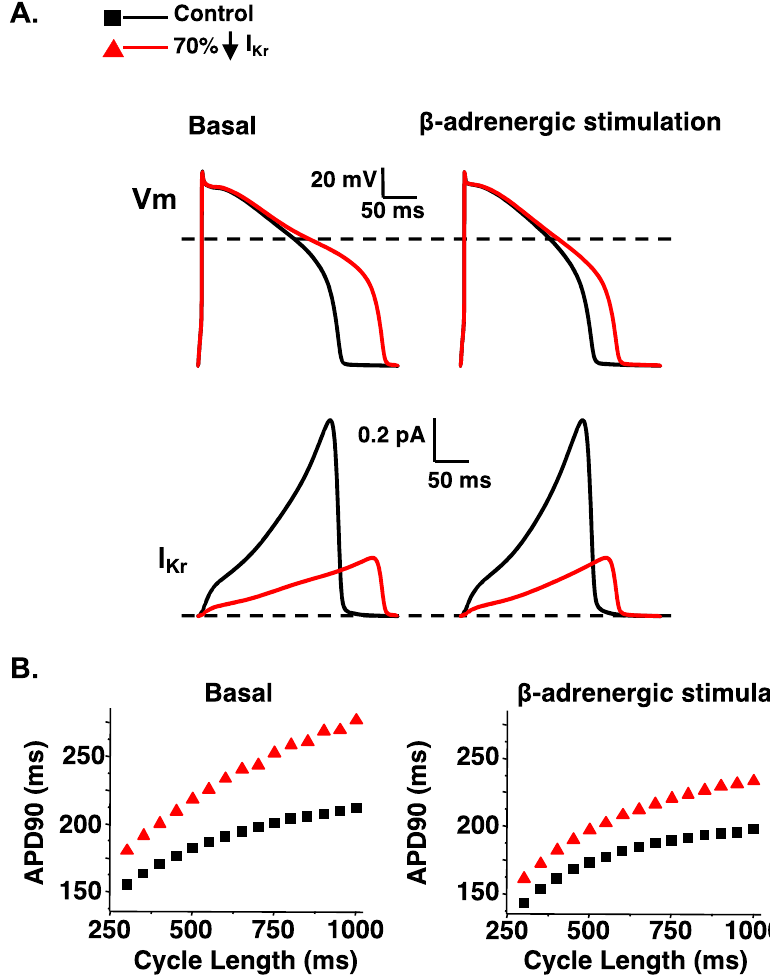
Figure 4. A reduction in I Kr predicts a disproportionate prolongation in the AP duration in the absence of β -adrenergic stimulation. ( A ). Representative AP waveforms and the corresponding I Kr for control simulations (black line); simulations in which the I Kr component was reduced by 70% (red line). On the left shows basal conditions and on the right show conditions that simulate β -adrenergic stimulation. ( B ). The duration APD 90 was plotted as a function of the cycle length for basal conditions (left) or with β -adrenergic stimulation (right). Shown are the corresponding steady-state APD 90 calculated for simulations at cycle lengths between 300 and 1000 ms for control simulations (black squares) and simulations in which the I Kr component was reduced by 70% (red triangles) in basal conditions (left) or conditions that mimic β -adrenergic stimulation (right). Some data was adapted from (SEE ORIGINAL REFERENCE 123 Smith et al. 2016) [67].